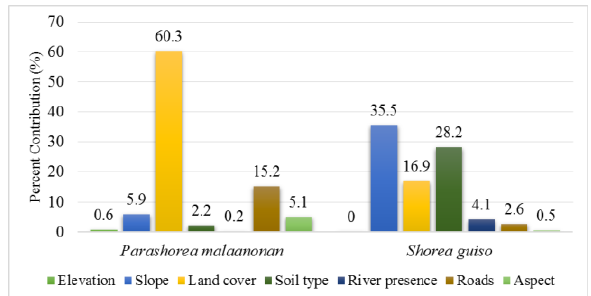
Figure 3. Percent contribution of biophysical variables derived from Maxent models and its influence on the geographic distribution of P. malaanonan and S. guiso